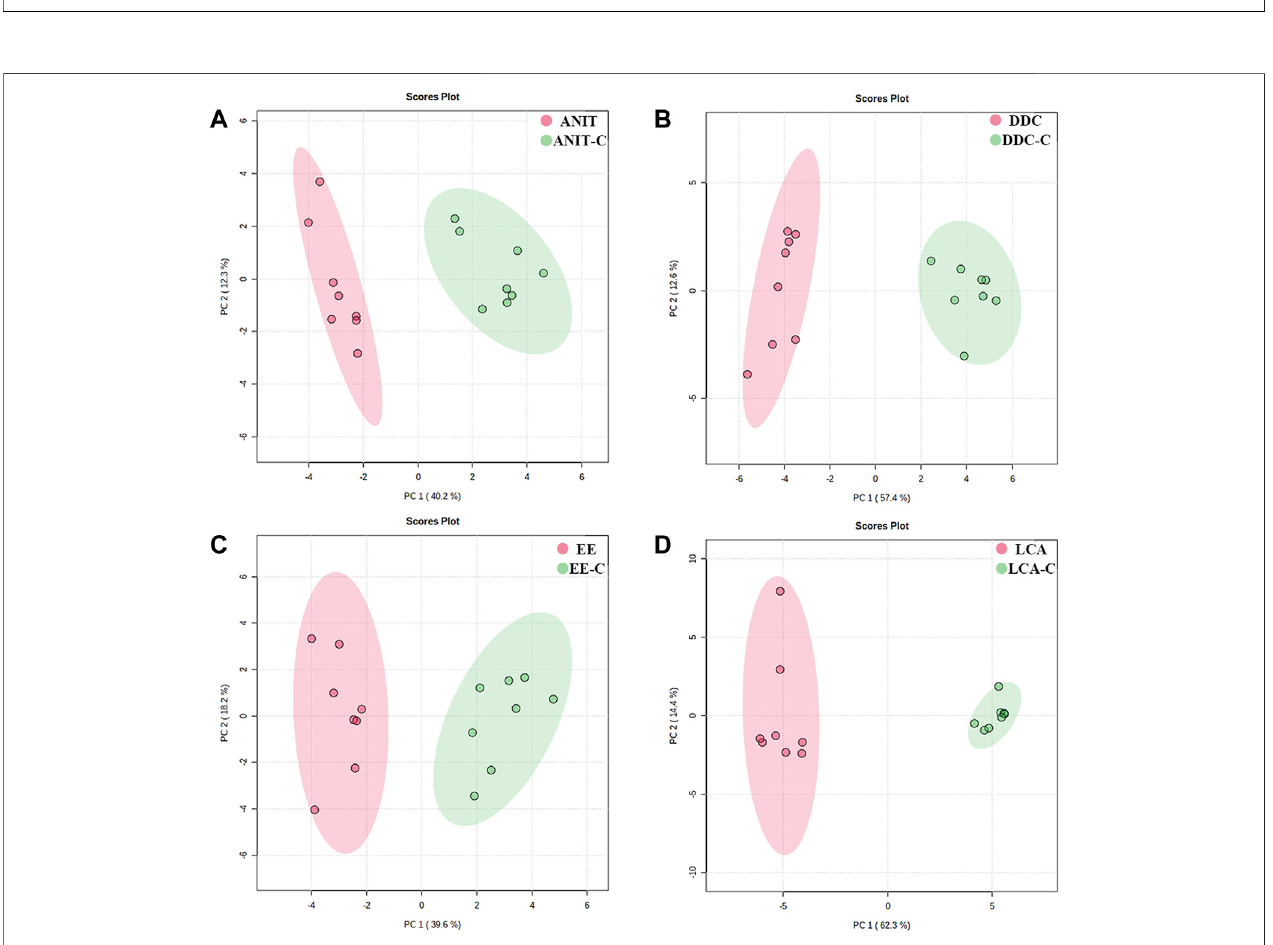
FIGURE8| PCAscoreplotsbasedontheGC-MSpro fi lingofthefourmodelsversustheirNCgroups. (A) ANITgroupvs.ANIT-Cgroup. (B) DDCgroupvs.DDC-C group. (C) EE group vs. EE-C group. (D) LCA group vs. LCA-C group. (n = 8).